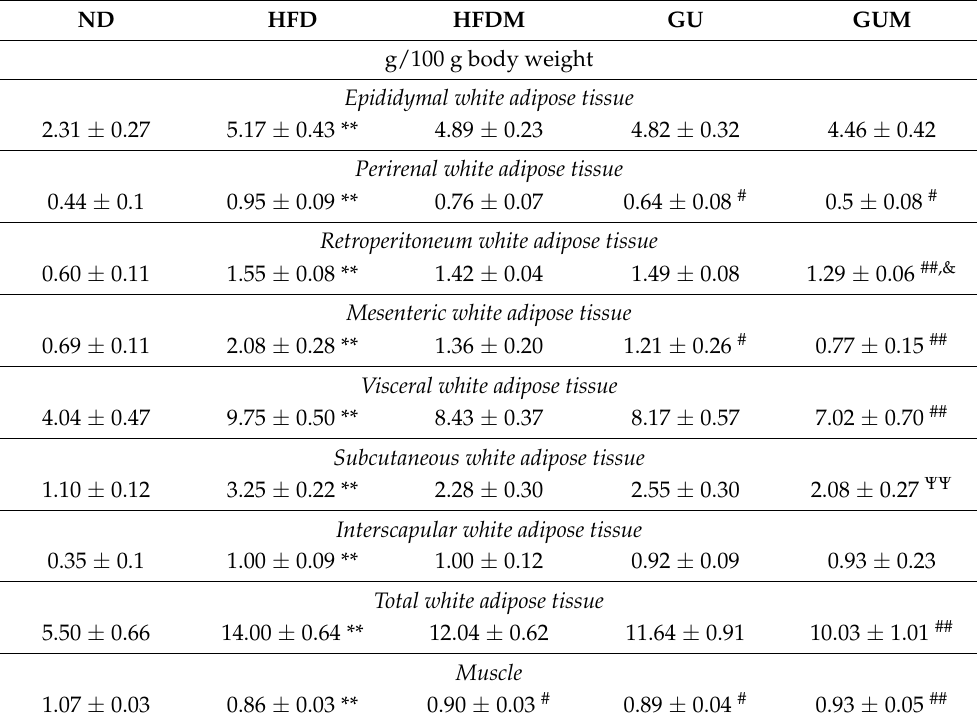
Table 1. Effect of metformin, G. uralensis Fischer, and their combination after 16 weeks on adipose tissue weights in C57BL/6J mice fed a high-fat